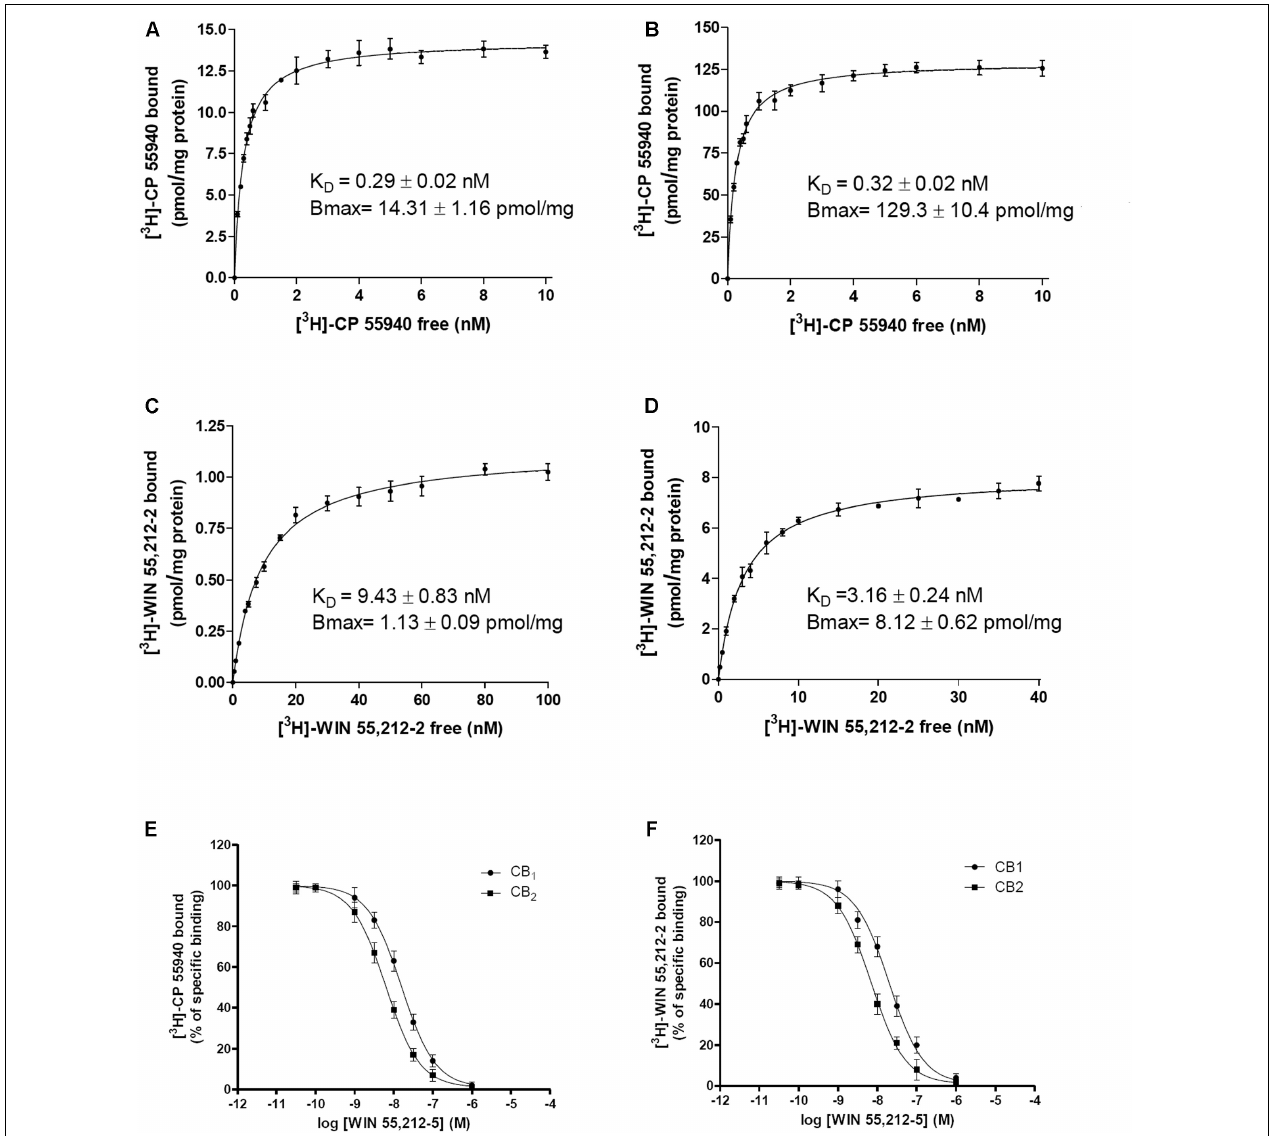
FIGURE 1 | Radioligand binding assays to CB 1 R and CB 2 R. (A–D) Saturation curves of either [ 3 H]-CP-55940 or [ 3 H]-WIN-55,212-2 binding on membranes from CHO cells stably expressing human CB 1 R (A,C) or CB 2 R (B,D) . (E,F) Competition curves for WIN-55,212-2 in radioligand-based assays using either [ 3 H]-CP-55940 (E) or [ 3 H]-WIN-55,212-2 (F) binding on membranes from CHO cells stably expressing human CB 1 R or CB 2 R. Data are expressed as the mean ± SEM of five independent experiments performed in duplicate. K D (obtained from saturation isotherms) are shown in Table 1